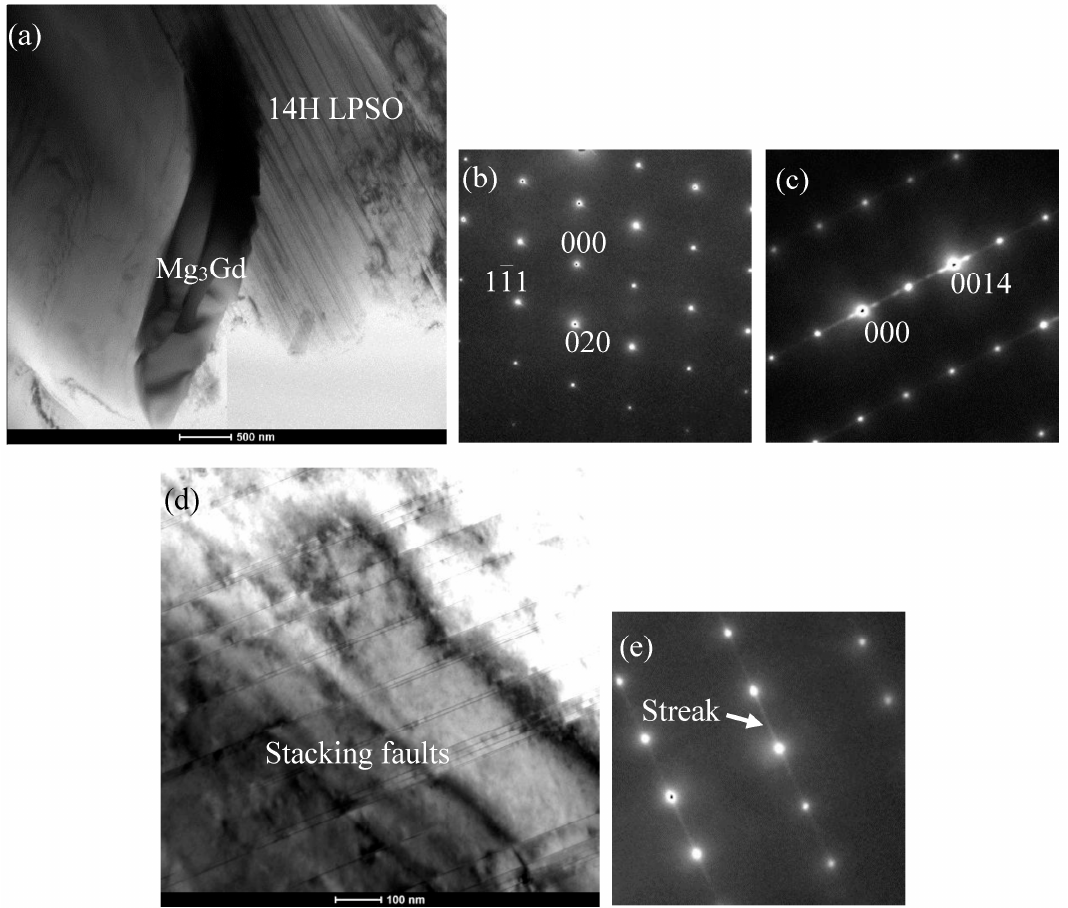
Figure 5. TEM (transmission electron microscope) micrographs of as-cast alloy: ( a ) Mg 3 Gd phase and long period stacking ordered (LPSO) phase; selected area electron diffraction (SAED) patterns of ( b ) Mg 3 Gd phase and ( c ) LPSO phase; ( d ) the center area of α -Mg grain and ( e ) its corresponding SAED pattern.